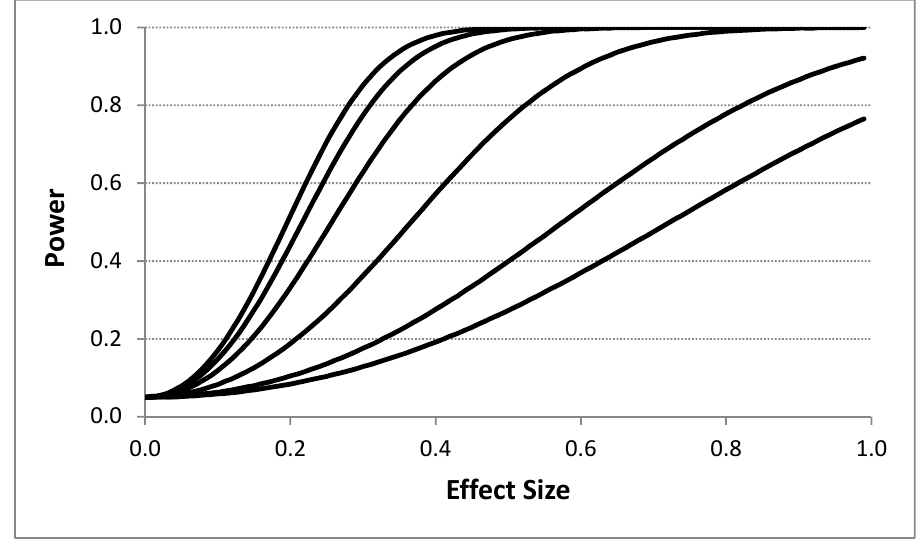
Figure 2. Influence of the effect size (i.e., difference between intervention responses in standard deviation units) on power assuming four intervention periods and 400 total observations (i.e., 8 intervention administration periods overall with 50 observations; a ‘4p × 2i’ design as described in the text) with no washout periods based on the proposed analytical model. Each line corresponds to a different assumed serial correlation strength. The upper most line represents a 0.0 serial correlation, with successive lines below it reflecting serial correlations of 0.1, 0.25, 0.5, 0.75, and 0.9, respectively. A type I error rate of 0.05 was assumed.